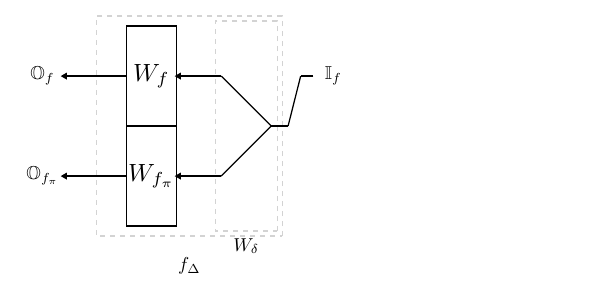
Figure 3: The vulnerability profile of a function corresponds to the tensor product of the regular Walsh transform of a function and of its probes f